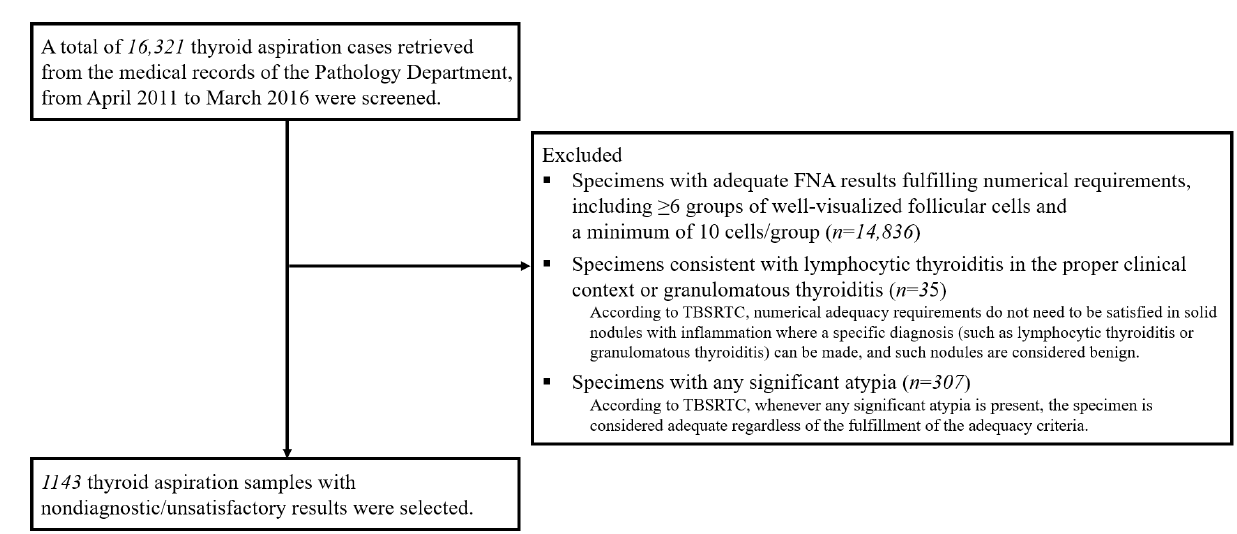
Figure 1. Steps for case selection. TBSRTC = the Bethesda system for reporting thyroid cytopathology [15,16]